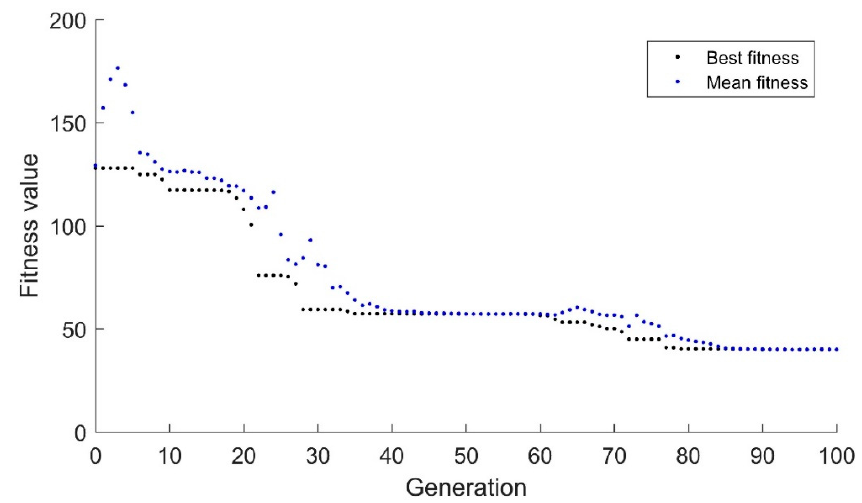
Figure 4. A binary genetic algorithm responding to a sudden jump in the target value after initial convergence.